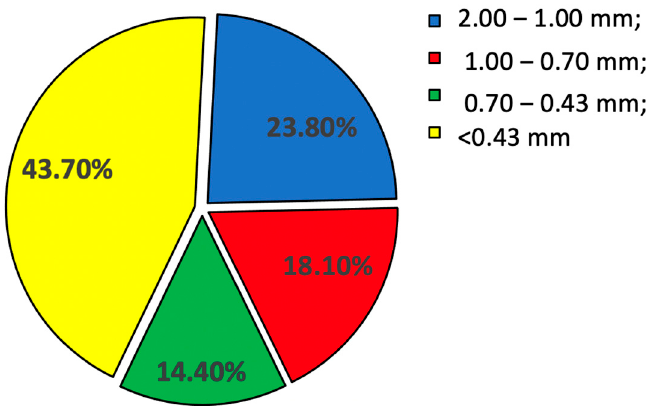
Figure 7. Percentage mass content of polymetallic nodule particles of different sizes, crushed in a jaw crusher.